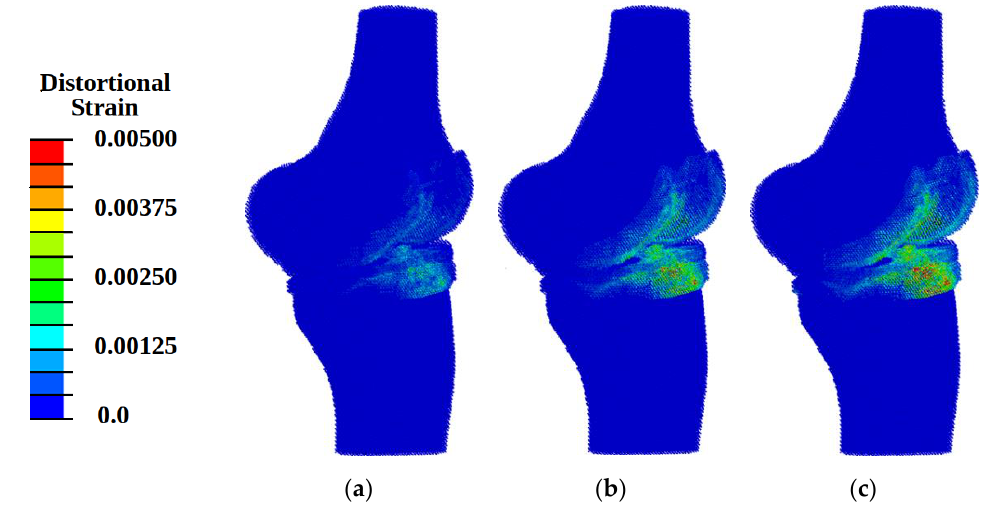
Figure 9. Fields of distortional strain at different energy flux density of shock wave: ( a ) 0.12 mJ/mm 2 ; ( b ) 0.33 mJ/mm 2 ; ( c ) 0.8 mJ/mm 2 .